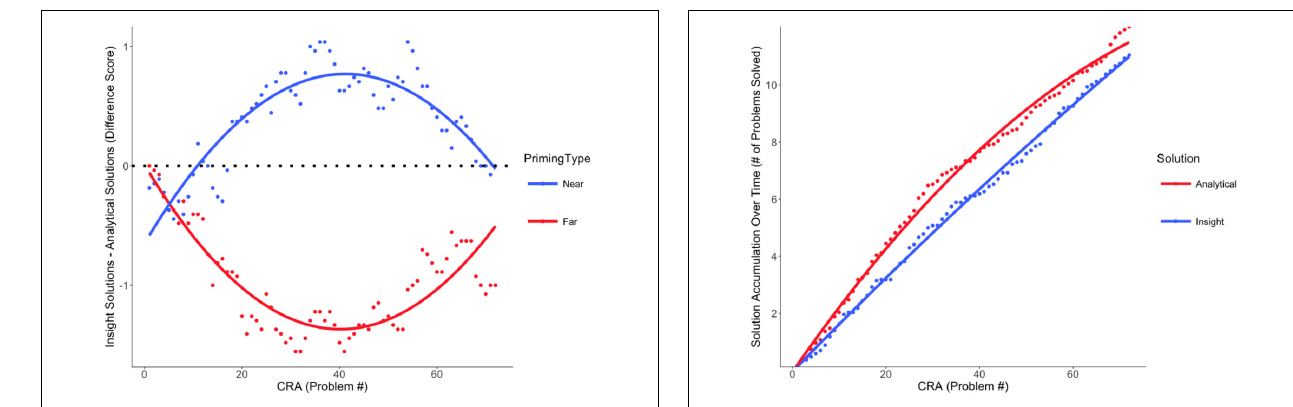
FIGURE 4 | Far-future priming solution accumulation. Model fit of the accumulated solutions (insight versus analytical) over the series of CRA problems in the far-future priming condition. Although participants used similar numbers of each solution type, analytical solutions initially accumulated more rapidly than insightful